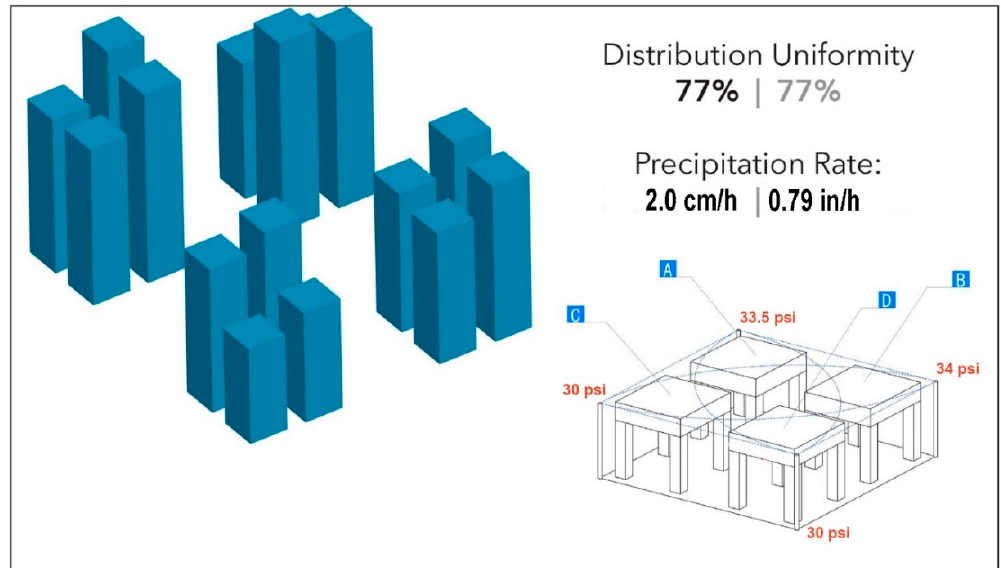
Figure 2. Graphical representation of distribution uniformity and the precipitation rate test results on the laboratory of substrate microcosms in laboratory rainfall simulations [52].